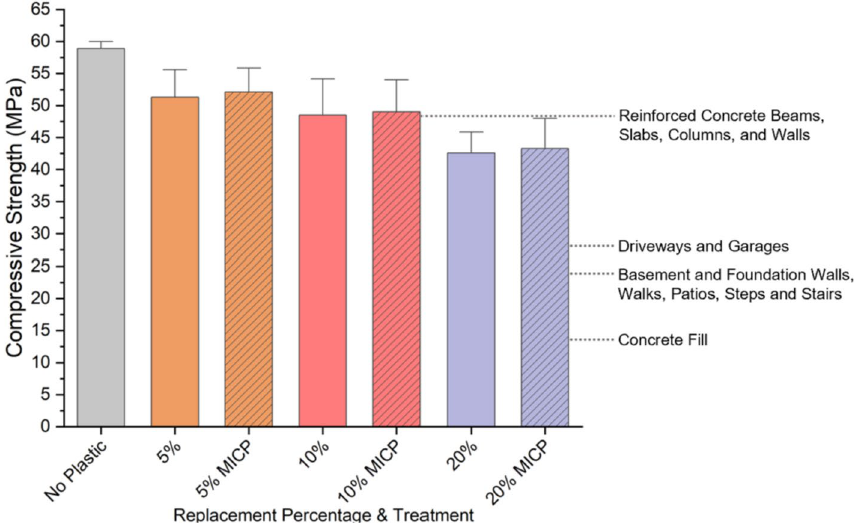
Figure 6. Compressive strengths at replacement percentages 5–20% with waste plastic and no treatment (solid) and MICP-treated waste plastic (striped). Strengths shown are averages across HDPE, PVC, LDPE1, LDPE2 at the given replacement percentage. The bar heights represent the mean, and the error bars indicate one standard deviation. The general compressive strengths shown for each type or location of concrete construction are the required strengths according to the International Code Council Concrete Manual: Based on the 2015 IBC ® and ACI 318–14. However, the strengths required for these applications may vary by design and